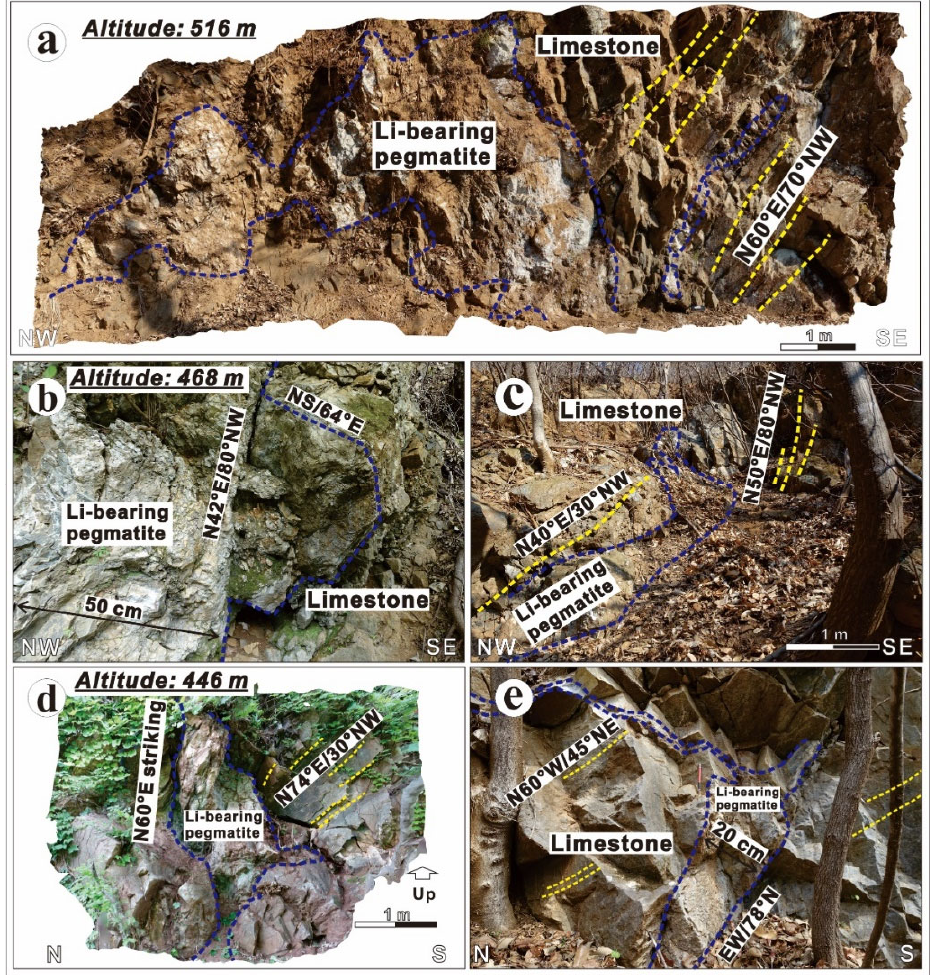
Figure 4. Upper (Pgt 1), middle (Pgt 2), and bottom (Pgt 3) parts of the western rare-element pegmatite (REP) bodies. The boundaries of the bodies are highlighted with thick blue dotted lines, and the beddings are highlighted with thick yellow dotted lines. ( a ) Pgt 1 is composed of an irregular body and more than two lenticular bodies. ( b , c ) Pgt 2 is composed of two REP bodies parallel to the bedding and is branched or bent by a N–S-striking fracture and rotation of the bedding, respectively. ( d , e ) Pgt 3 consists of two REP bodies that cross the bedding, with thin REP bodies branching along the bedding. Yellow and blue dotted lines indicate beddings and orebody contacts, respectively.